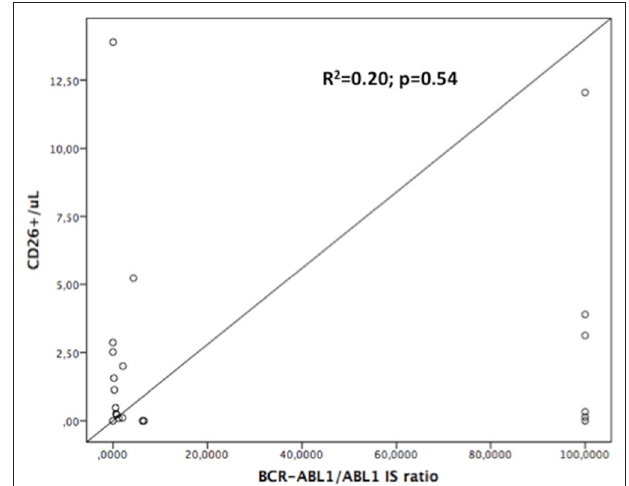
FIGURE 2 | Linear regression curve: CD34 + /CD26 + number is not significantly correlated with BCR-ABL1/ABL1 expression, either at diagnosis or during follow-up. R 2 = 0.20; p =